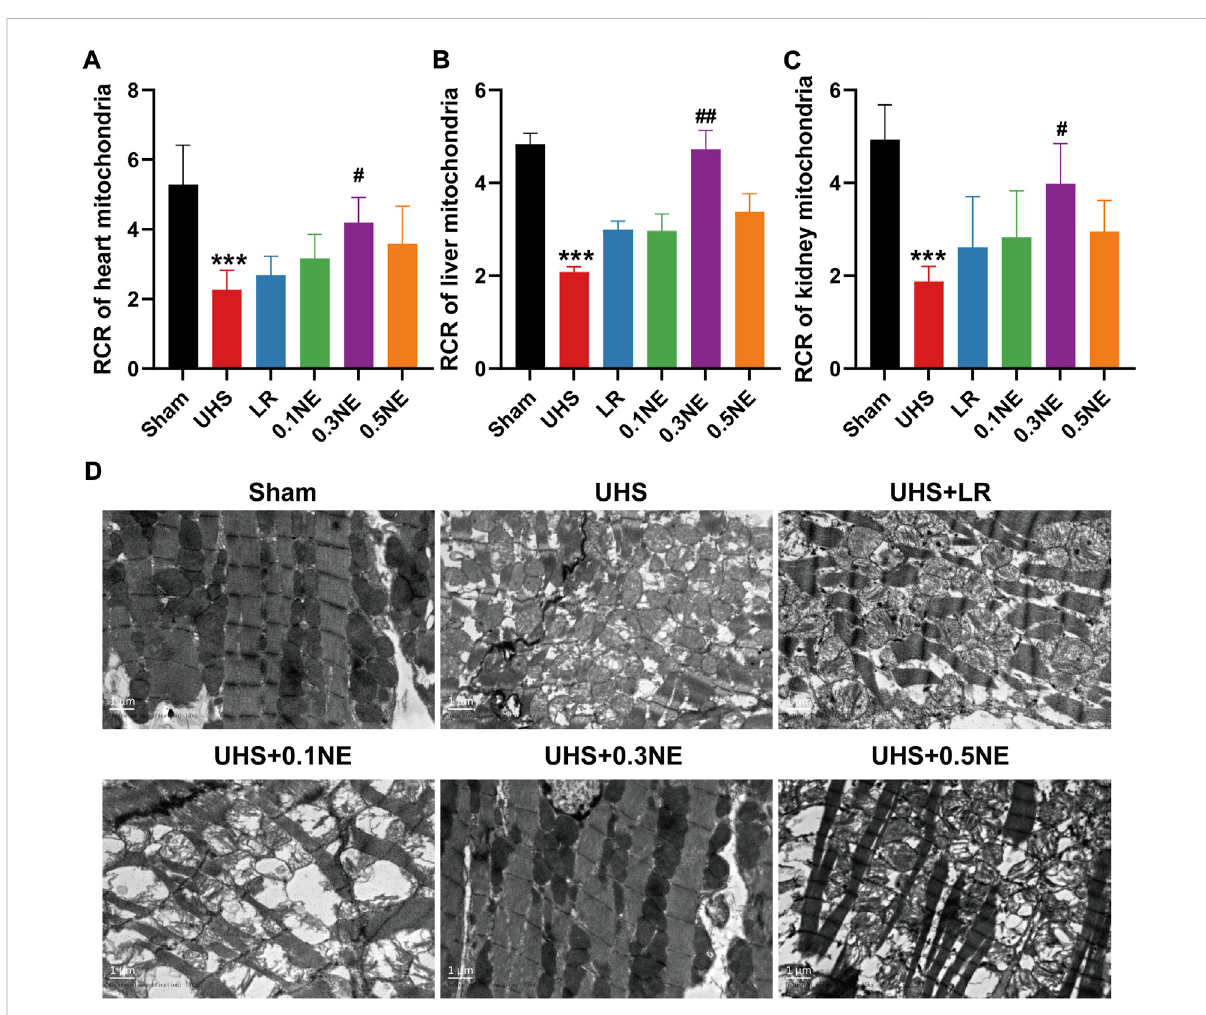
FIGURE 8 The effect of NE on mitochondrial function of the vital organ following 1 h of hypotensive resuscitation. (A – C) The RCRs of mitochondria in heart, liver, and kidneys. *** p ＜ 0.001 as compared with the Sham group. # p ＜ 0.05, ## p ＜ 0.01 as compared with the LR group. (D) Mitochondrial morphology of heart by transmission electron microscope (TEM).